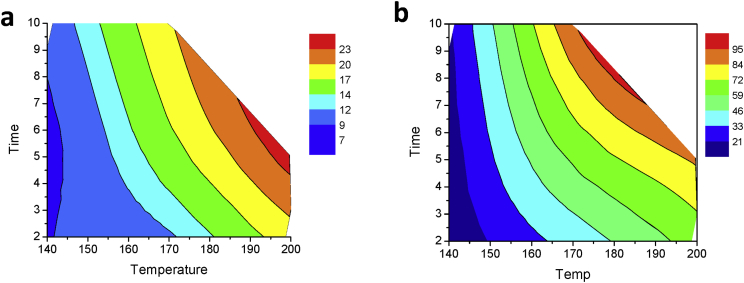
Contour plot representation of the interaction between the operating conditions, time (t) and temperature (T) for: a) total soluble solids mass yield [ηtotal soluble solids, (%, w/w)]; and b) arabinogalactans content [ηAG, (mgAG/gSCG)].